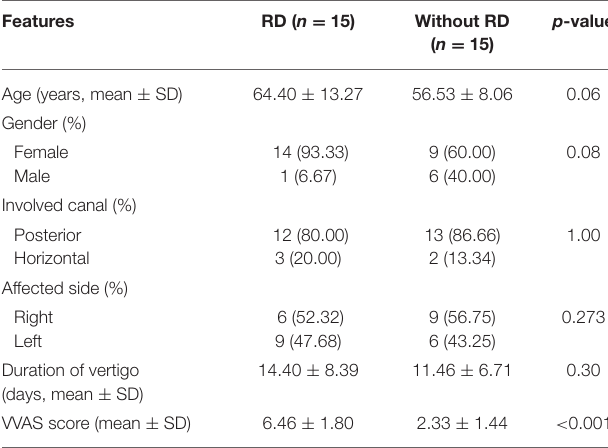
TABLE 1 | Demographic and clinical characteristics of patients with and without RD.